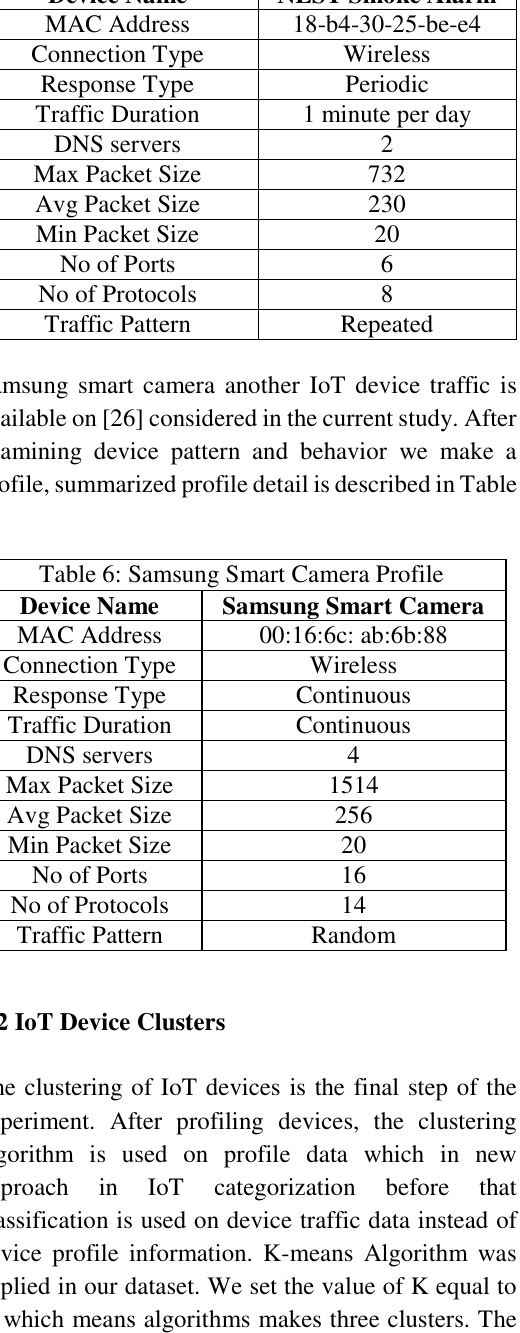
Table5: NEST Smoke Alarm Profile